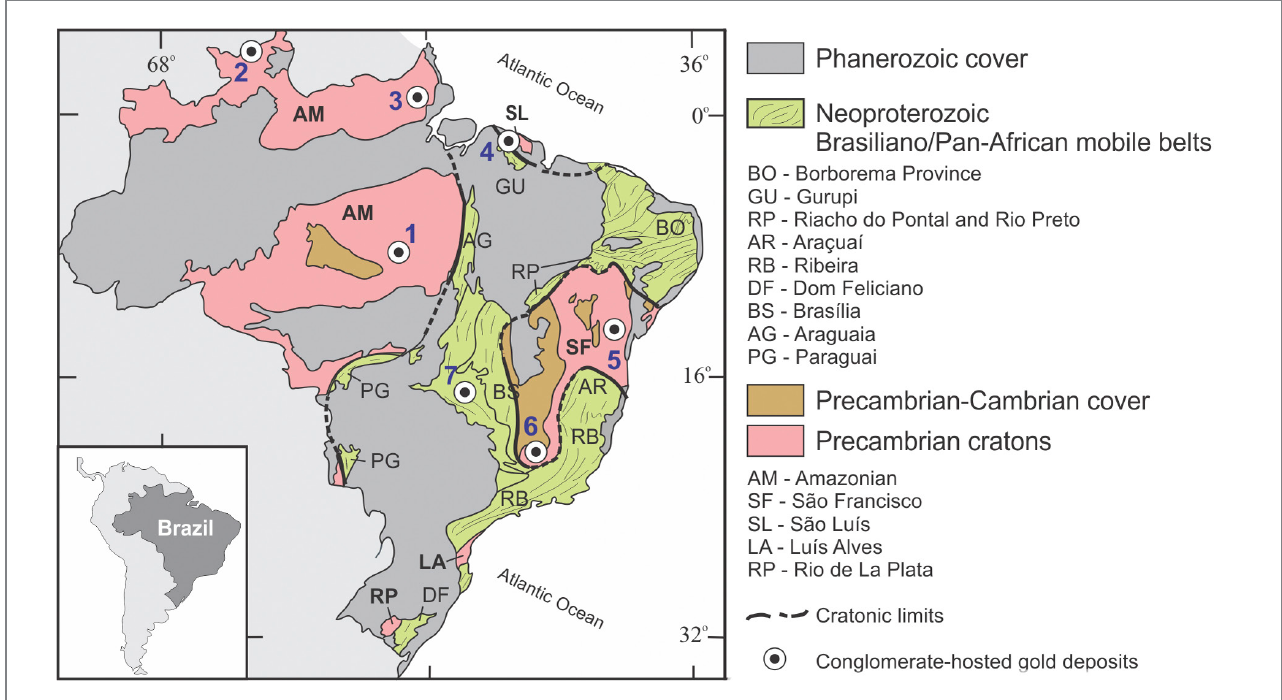
Figure 1 - Major tectonic units of Brazil with the location of (1) Castelo de Sonhos and other conglomerate-hosted gold deposits: 2 – Roraima, 3 – Vila Nova, 4 – Igarapé de Areia, 5 – Jacobina, 6 – Moeda, 7 –